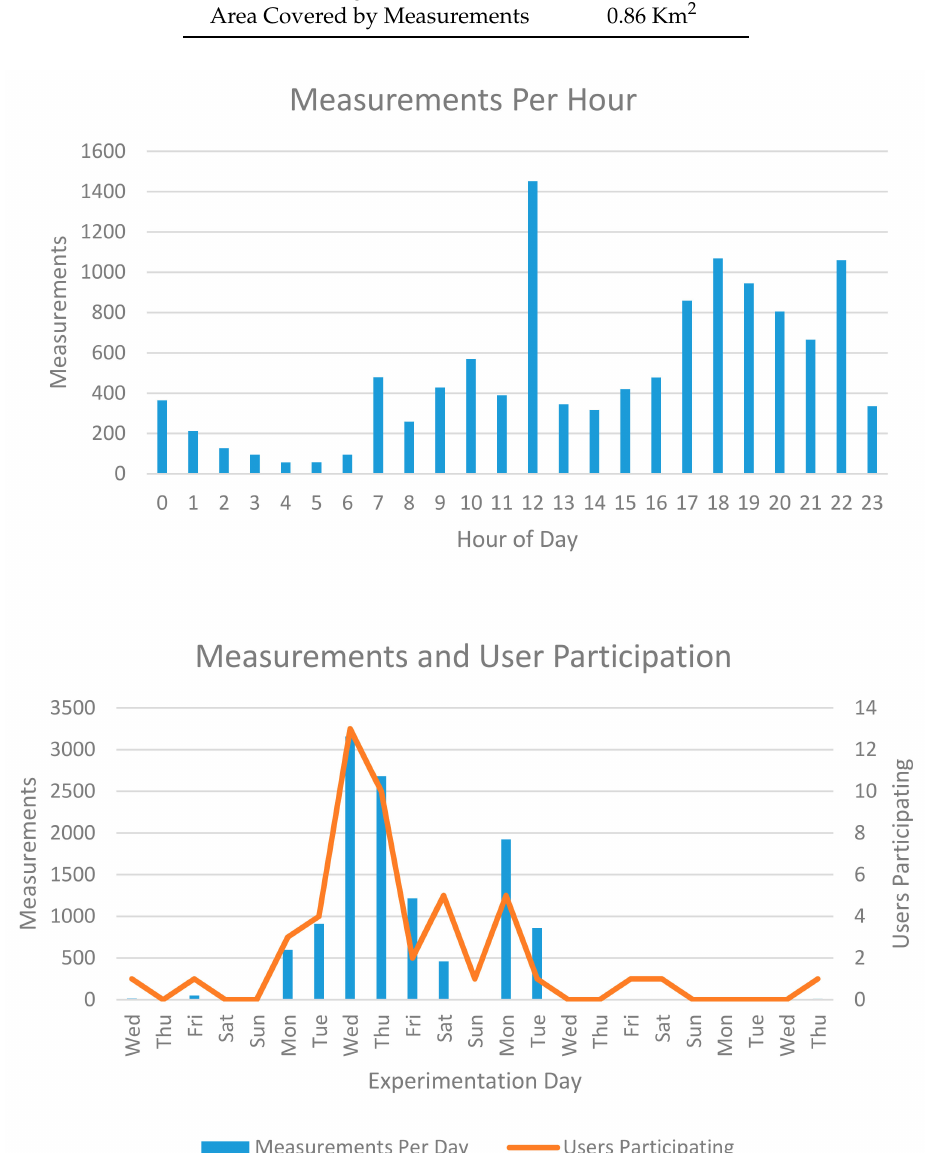
Figure 6. Results from the sensing campaigns